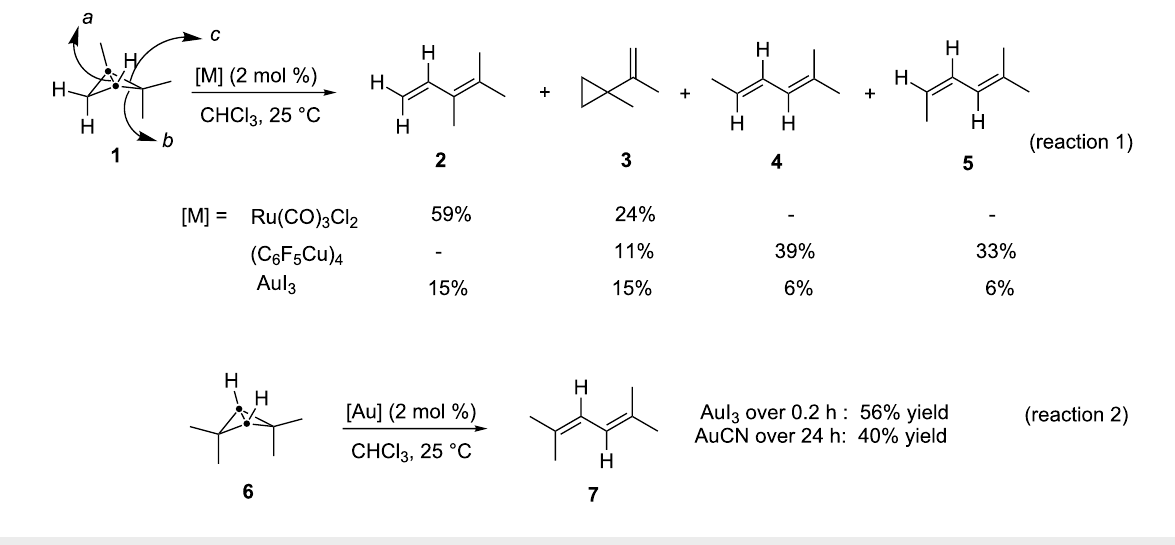
studies on transition metal promoted rearrangements